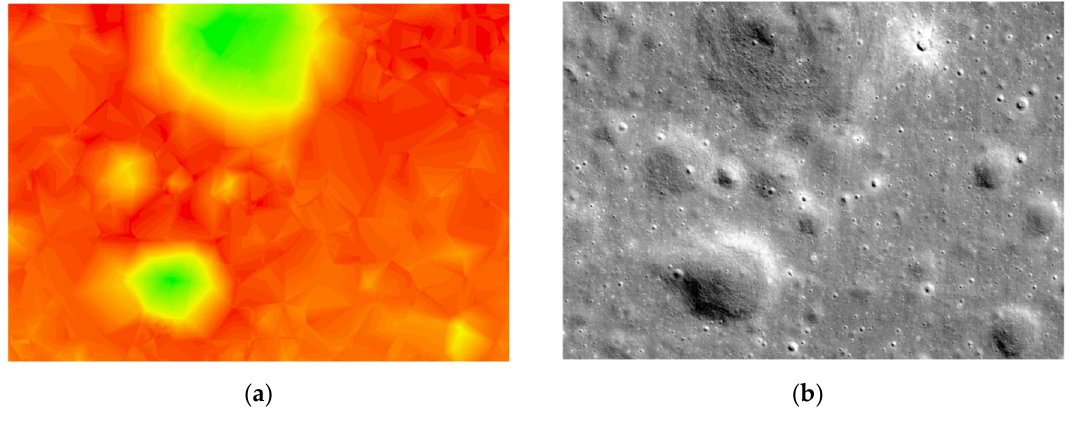
Figure 4. ( a ) DEM and ( b ) DOM for rover image simulation.